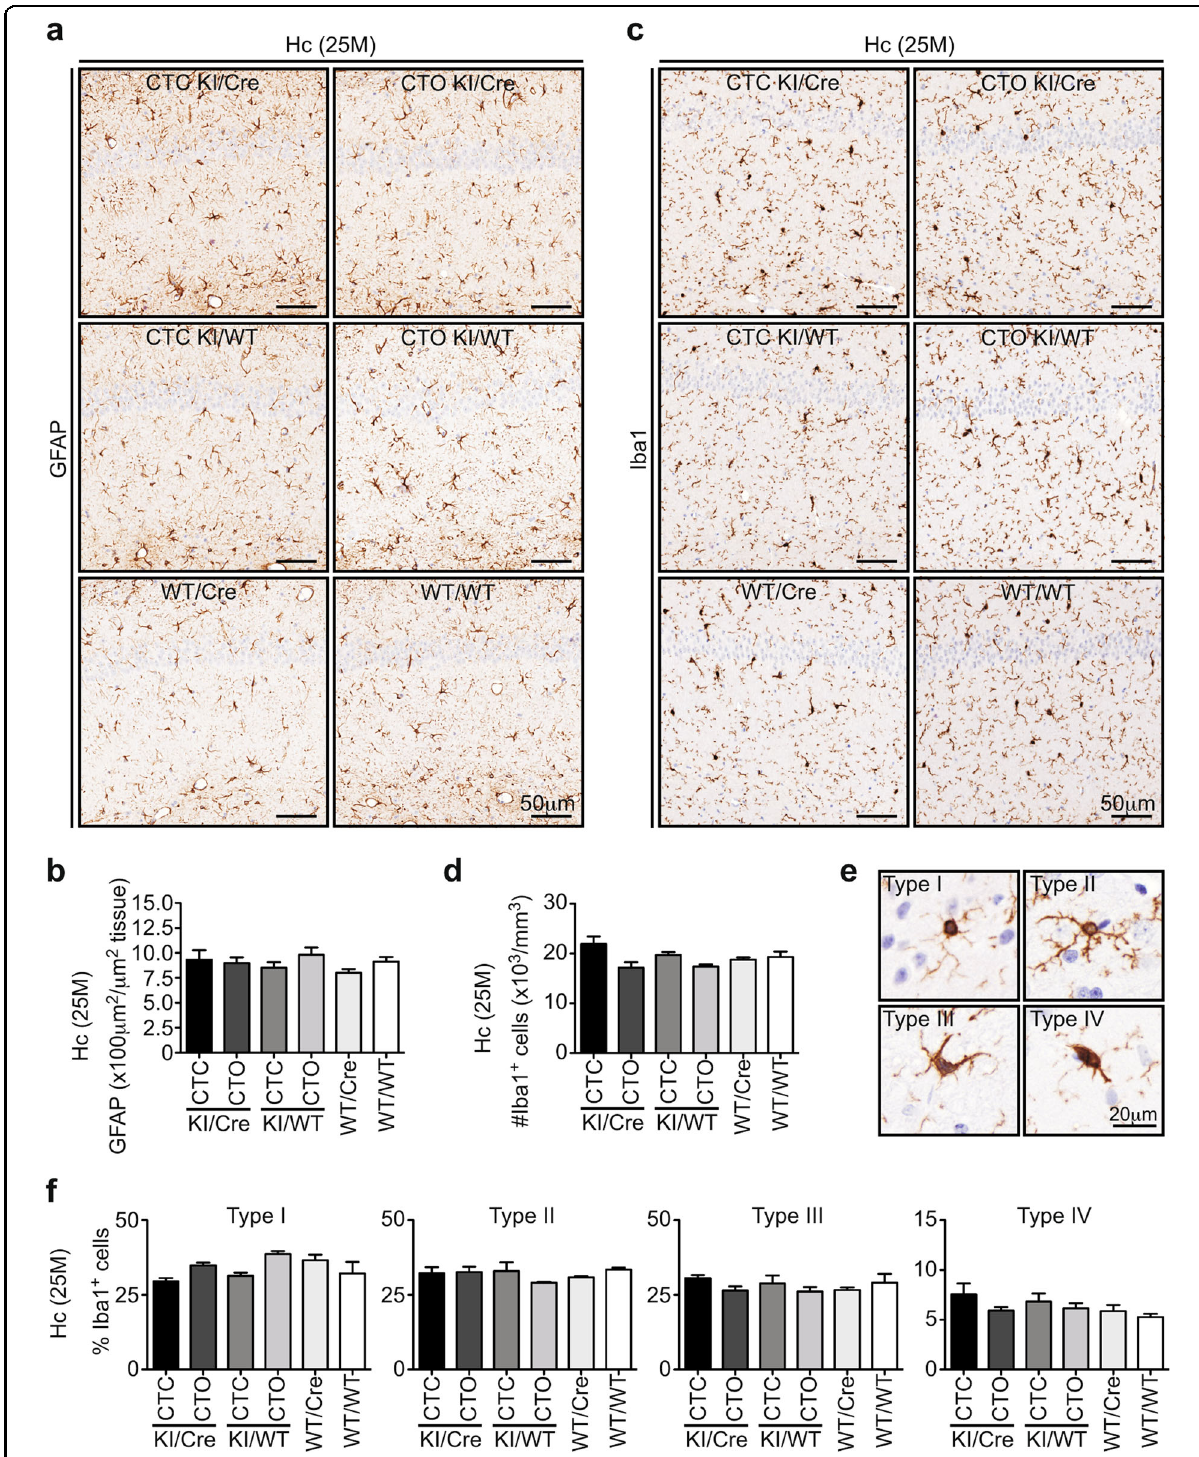
Fig. 5 Old CTC KI/Cre mice do not display neuroin fl ammation in the hippocampus. a Representative micrographs and b quanti fi cations of 25- month-old CTC and CTO KI/Cre, CTC, and CTO KI/WT, WT/Cre or WT/WT hippocampus tissue sections immunostained with anti-GFAP. c – f Representative micrographs and quanti fi cations of 25-month-old CTC KI/Cre, CTO KI/Cre, CTC KI/WT, CTO KI/WT, WT/Cre, or WT/WT hippocampus tissue sections immunostained with anti-Iba1. Data represent the mean ± SEM. n = 3/genotype. Statistical evaluations were done with one-way ANOVA followed by a Bonferroni ’ s post-hoc analysis. Hc